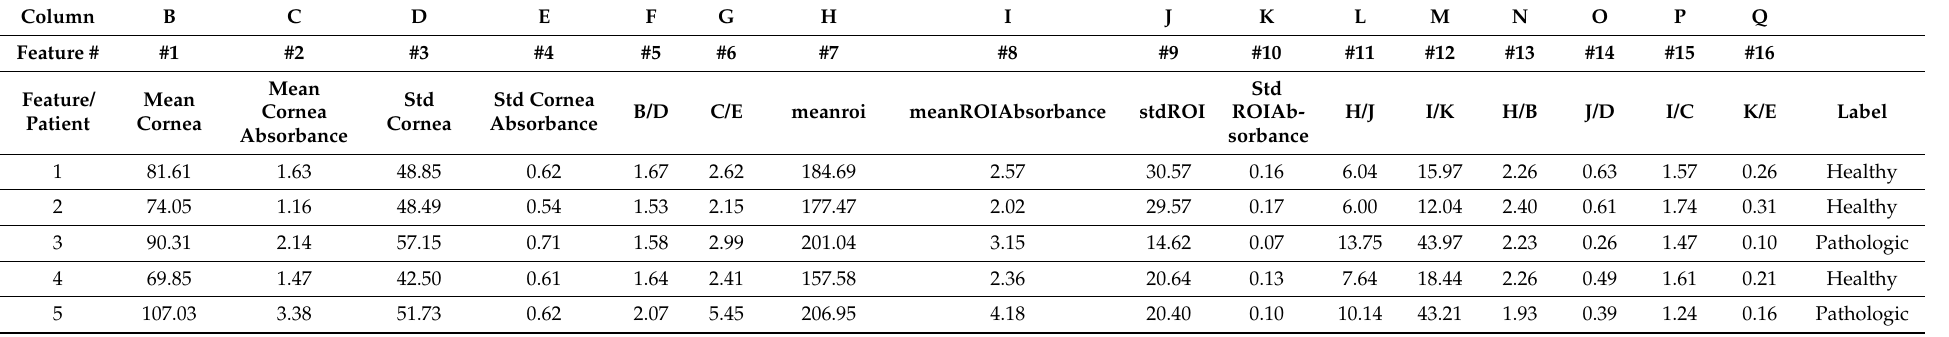
Table 1. Sample of statistical features retrieved from all corneal SD-OCT digital images. Mean: mean intensity value; std: standard deviation value; “/”: ratio of two